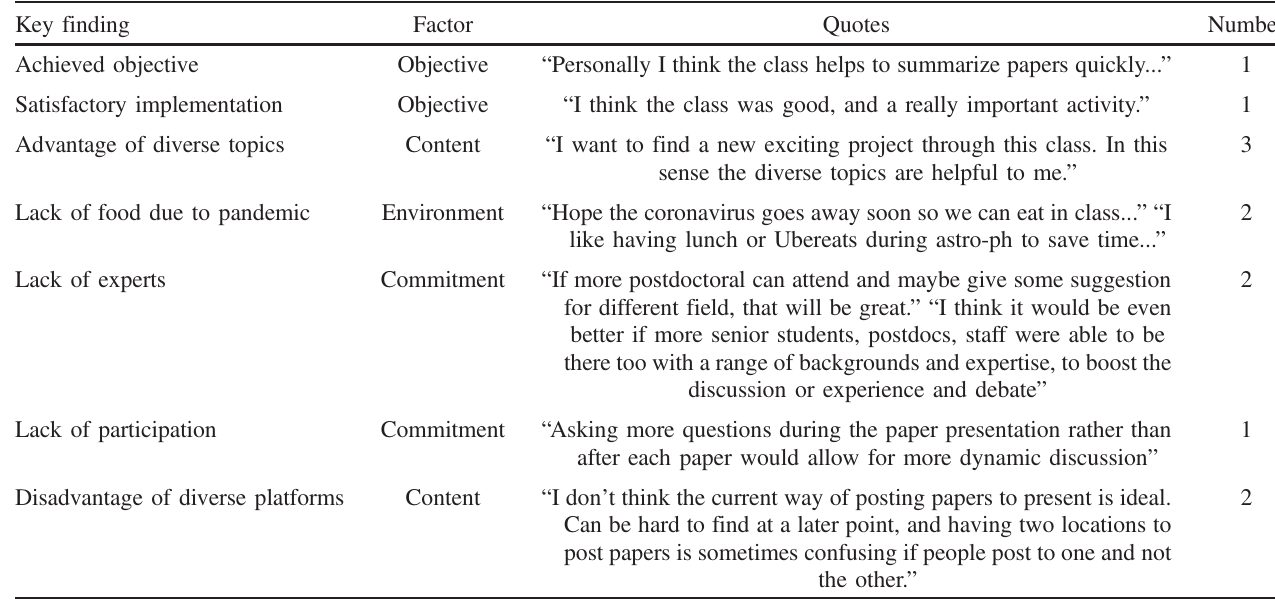
TABLE VII. Key findings from the comments and suggestions that we gathered from our participants. The factors where the key findings fall into and some direct quotes from the participants are also shown below. The number of suggestions or responses coded for each key finding are shown in the rightmost